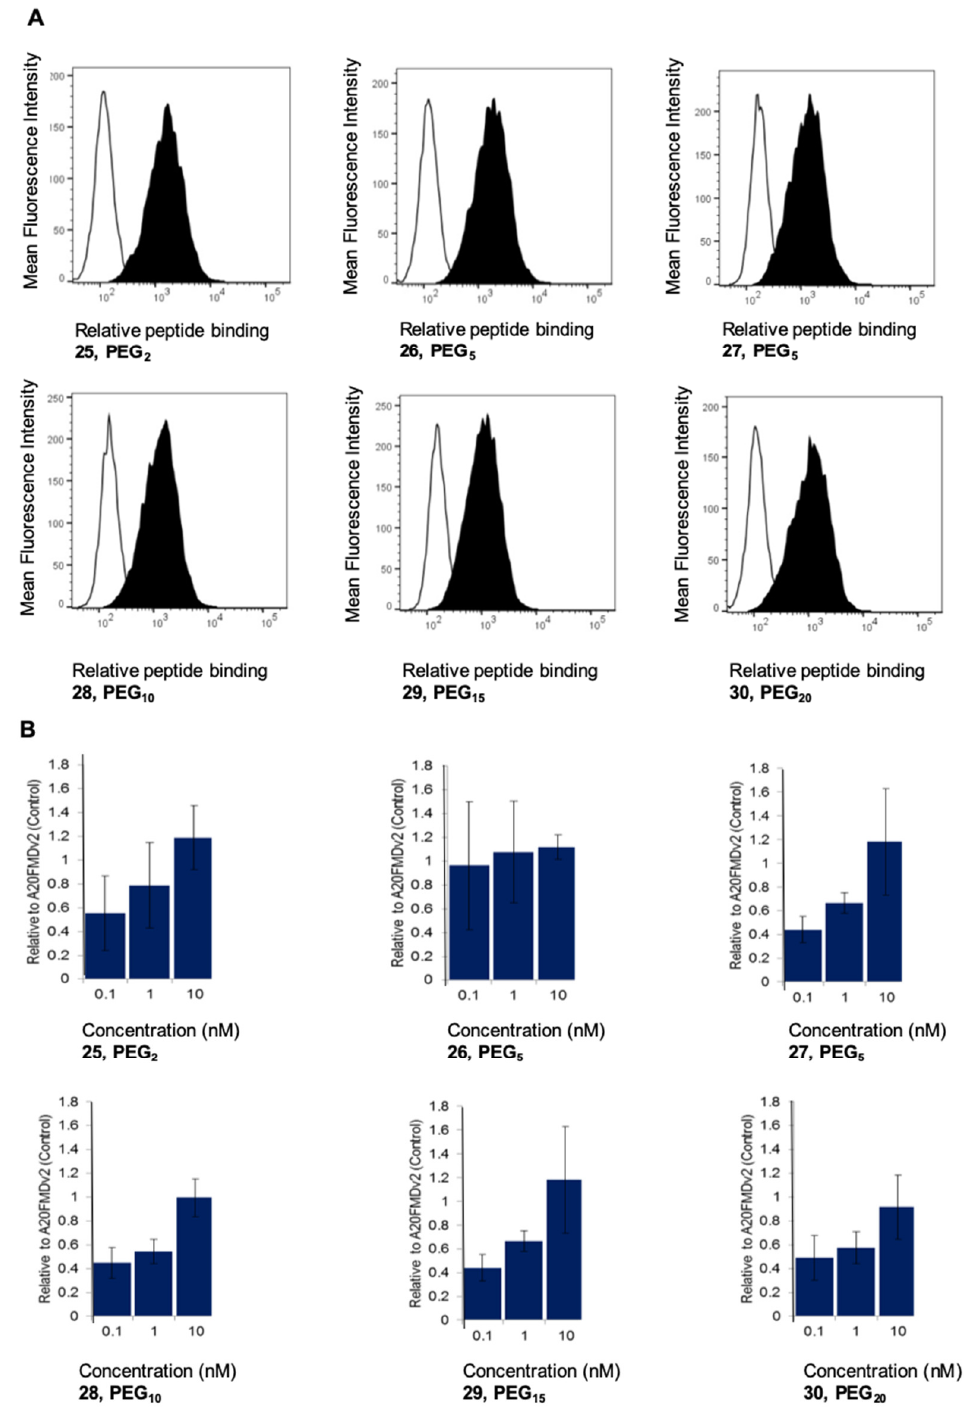
Figure 4. ( A ) Specificity of PEGylated DTPA-[ 2 Ala to Lys( D -biotin)]A20FMDV2 analogues ( 25 – 30 ) for integrin αvβ6 by flow cytometry; the binding of the peptide (1000 nM) to αvβ6-negative A375Ppuro (white histogram) versus αvβ6-positive A375Pβ6 cells (black histogram). ( B ) Relative activity of PEGylated DTPA-[ 2 Ala to Lys( D -biotin)]A20FMDV2 analogues ( 25 – 30 ) for αvβ6 measured by the cell-bound fraction at various concentrations. Data show the binding relative to the same concentration of non-PEGylated DTPA-NK( D -biotin)VPNLRGDLQVLAQKVART as assessed by flow cytometry. Data show mean of three experiments +/− SD.